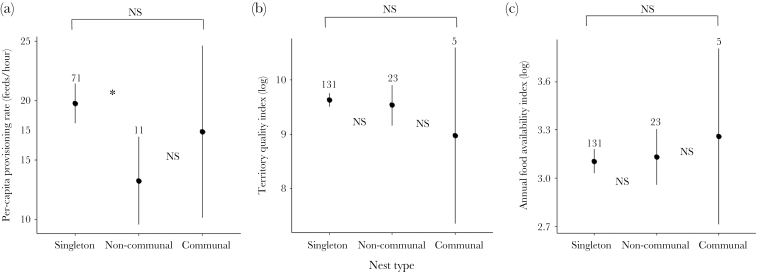
Differences in resource availability in terms of (a) per-capita provisioning rate, (b) territory quality, and (c) island-wide food availability between singleton and noncommunal, or singleton and communal broods in the Seychelles warbler. Dots and lines denote mean and standard error, respectively, numbers represent sample size per group. Significant (“*”) and nonsignificant (“NS”) differences between groups at P < 0.05 are displayed.